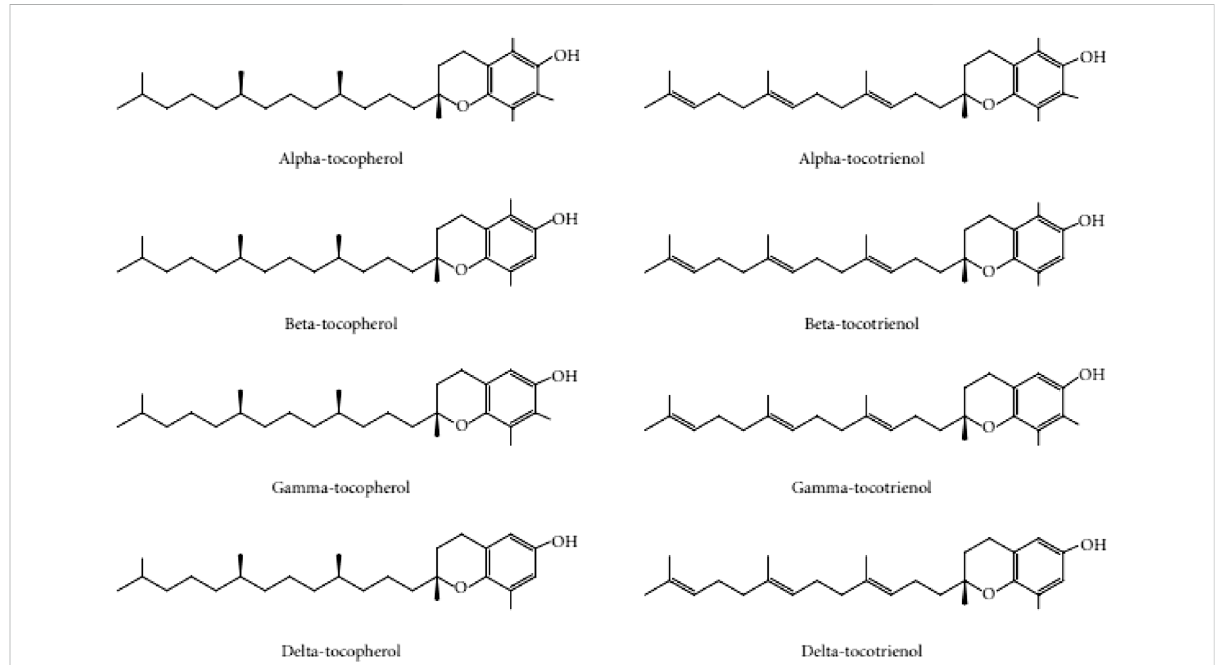
FIGURE 1 Tocopherol and tocotrienol structure adapted with permission from Chin and Ima-Nirwana